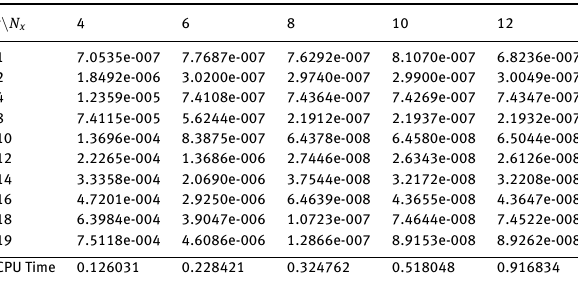
Table 8: Maximum errors E N for example 6 using N t = 5, m = s = 3 t \ N x